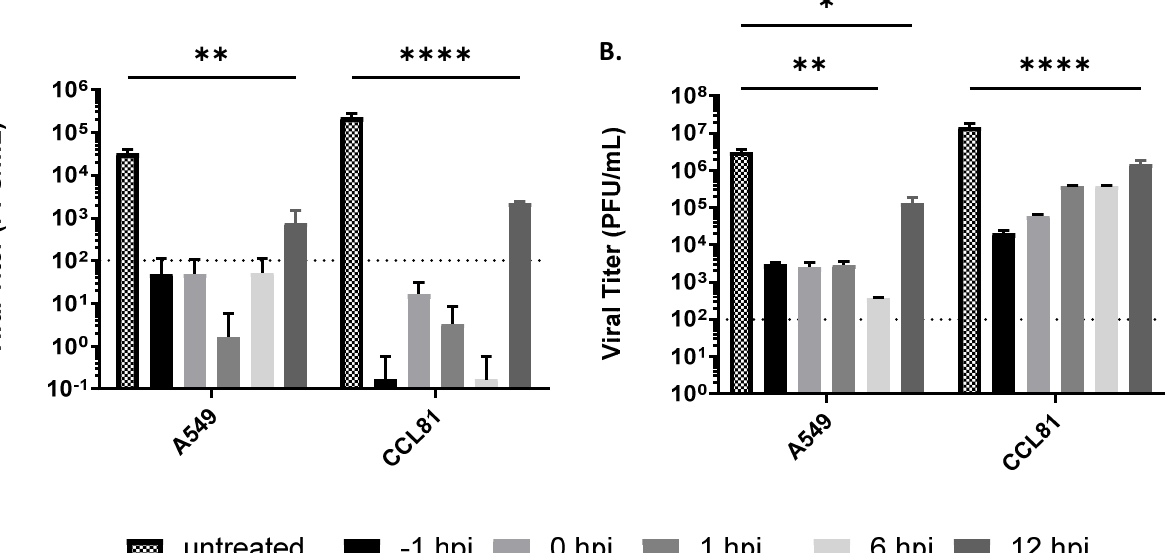
Figure 2. Delayed treatment in vitro efficacy of Tilorone against RVFV infection. A549 cells or Vero CCL81 cells were infected with RVFV MP12 ( A ) or ZH501 ( B ) at an MOI of 0.1 and treated with 50 µ M of Tilorone at the time points indicated. Virus titer in cell culture supernatant was evaluated by plaque assay at 24 h after infection. The dotted line represents the limit of detection in the plaque assay. * p < 0.05, ** p < 0.01, **** p < 0.0001.